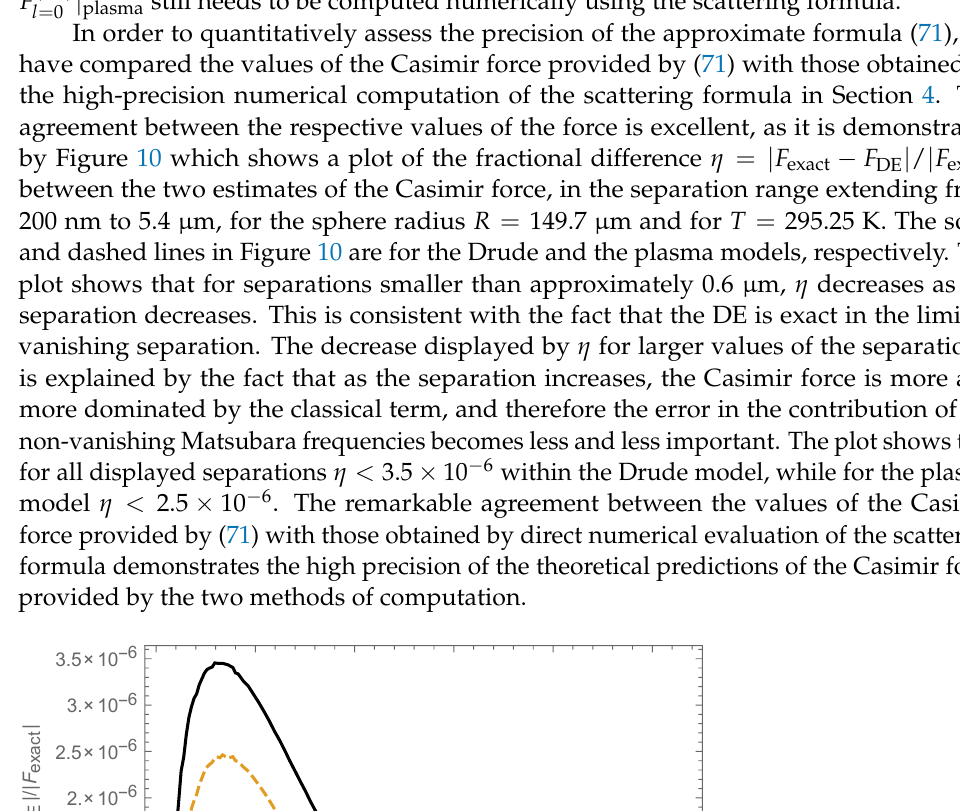
Figure 10. Fractional difference η = force F exact and the approximate formula (71), obtained from the DE for the nonzero Matsubara frequencies and exact result for the zero-frequency contribution. Sphere radius R = 149.7 µ m and T = 295.25 K. The solid and dashed lines are for the Drude and the plasma models,